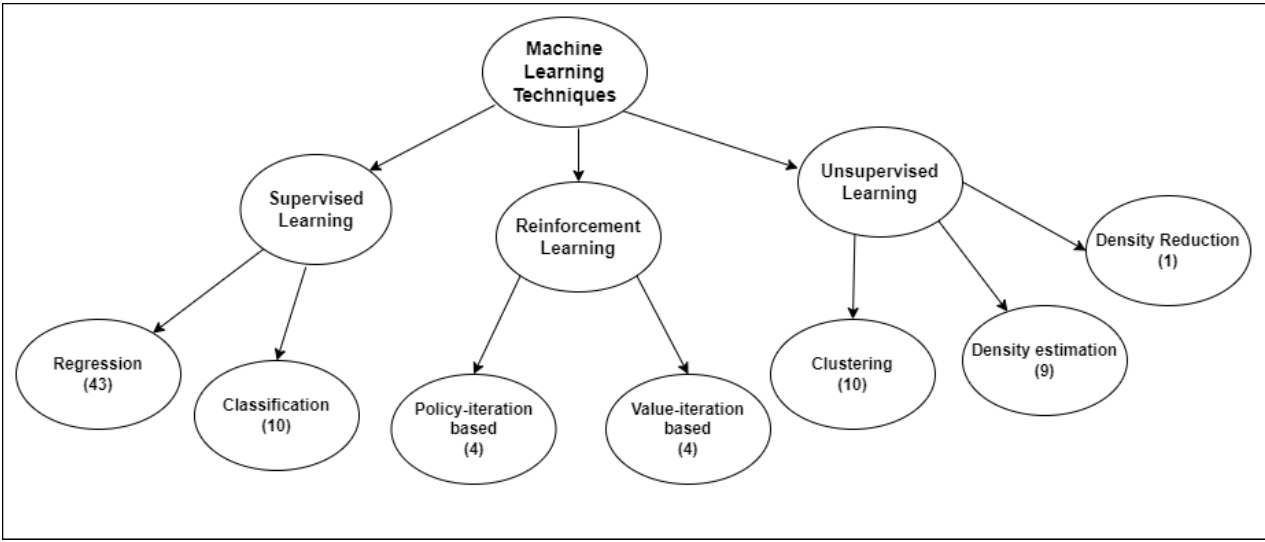
Figure 3. Machine learning